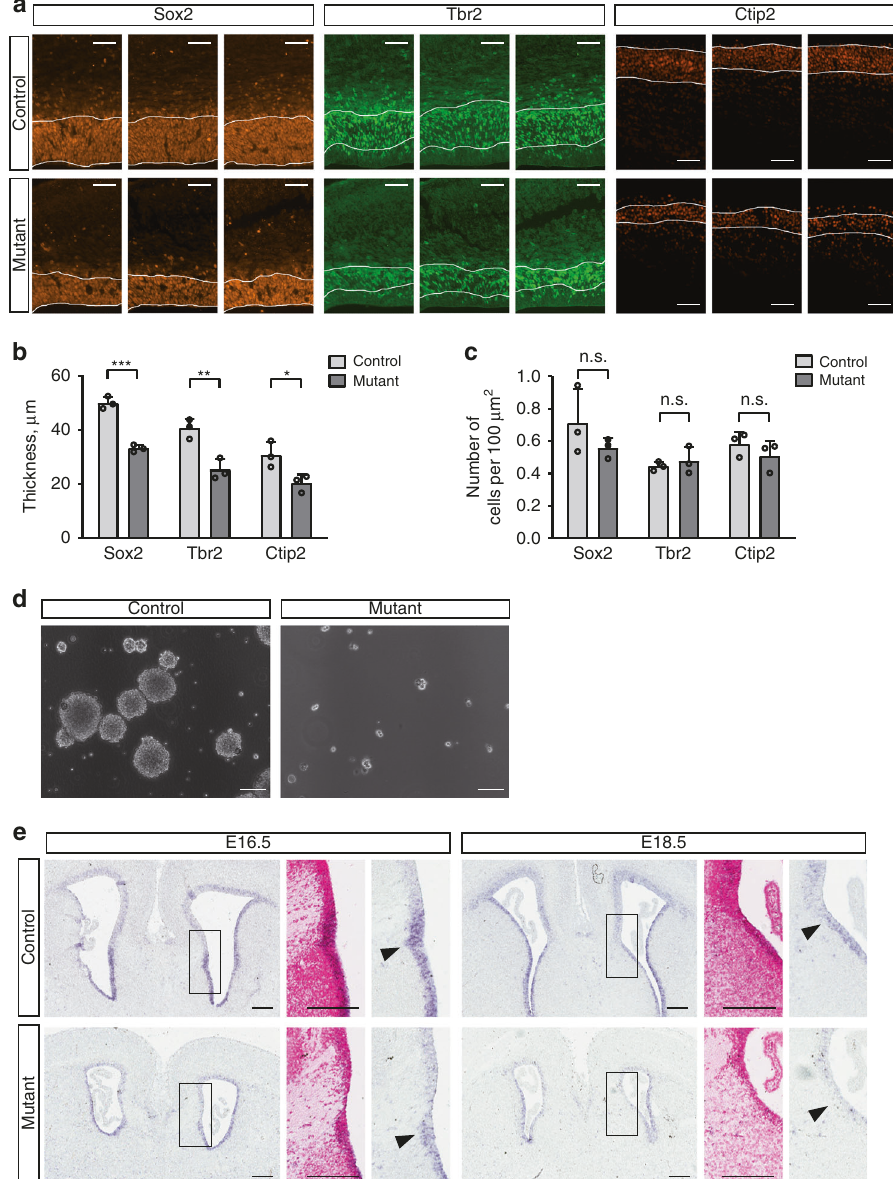
Fig. 4 Reduced neural stem and progenitor cells in the embryonic mutant brain. a Immunostainings of coronal forebrain sections from three mutant and three littermate control embryos at stage E14.5. b The thickness of the Sox2-, Tbr2-, and Ctip2-positive cortex layers is signi fi cantly reduced in the mutant compared to control animals. All bars display the mean with standard deviations. * p ≤ 0.05, ** p ≤ 0.01, *** p ≤ 0.001 (unpaired two-tailed Student ’ s t test). c Cell densities within the Sox2-, Tbr2-, and Ctip2-positive layers of the mutant compared with the control cortex. p values (unpaired two-tailed Student ’ s t test): n.s. not signi fi cant. d Cells isolated from the mutant forebrain of E15.5 embryos fail to form large neurospheres in comparison with cultures established from E15.5 control brain tissue. Cultures of passage one (3 days after passaging) are shown. e Hes5 expression in coronal brains sections from E16.5 and E18.5 mutant and control animals detected by in situ hybridization (blue signals). Enlarged regions (framed areas) include the site of glial wedge development (arrowheads). Nuclear fast red stainings were performed to visualize the region of corpus callosum development, which appears white due to the paucity of nuclei. Scale bars: 100 µ m ( a , d ), 200 µ m ( e ). Source data are provided as a Source Data fi